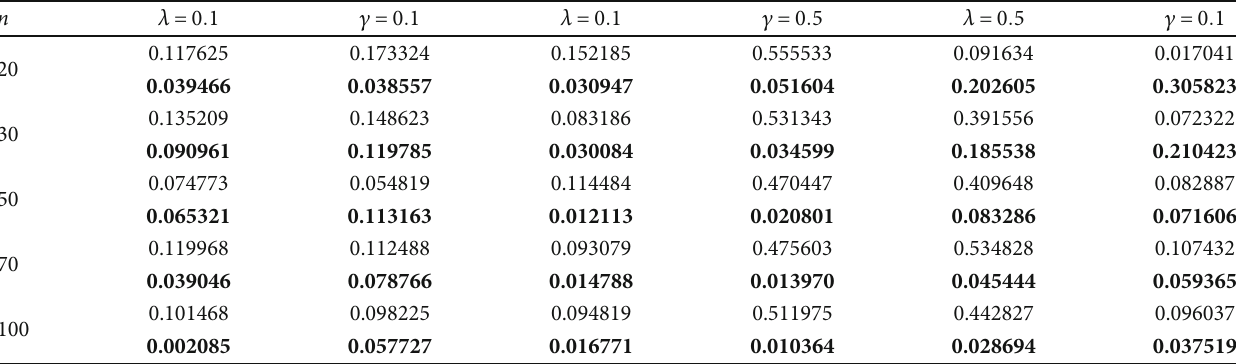
Table 8: BEs and PRs under ELF and informative prior using λ = 0 : 1, 0 : 5 and γ = 0 : 1, 0 : 5 .